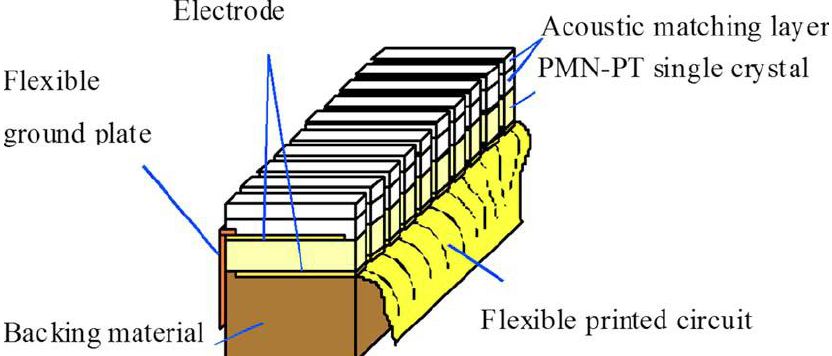
Figure 16. Schematic diagram of the PMN-PT phased array (with permission from